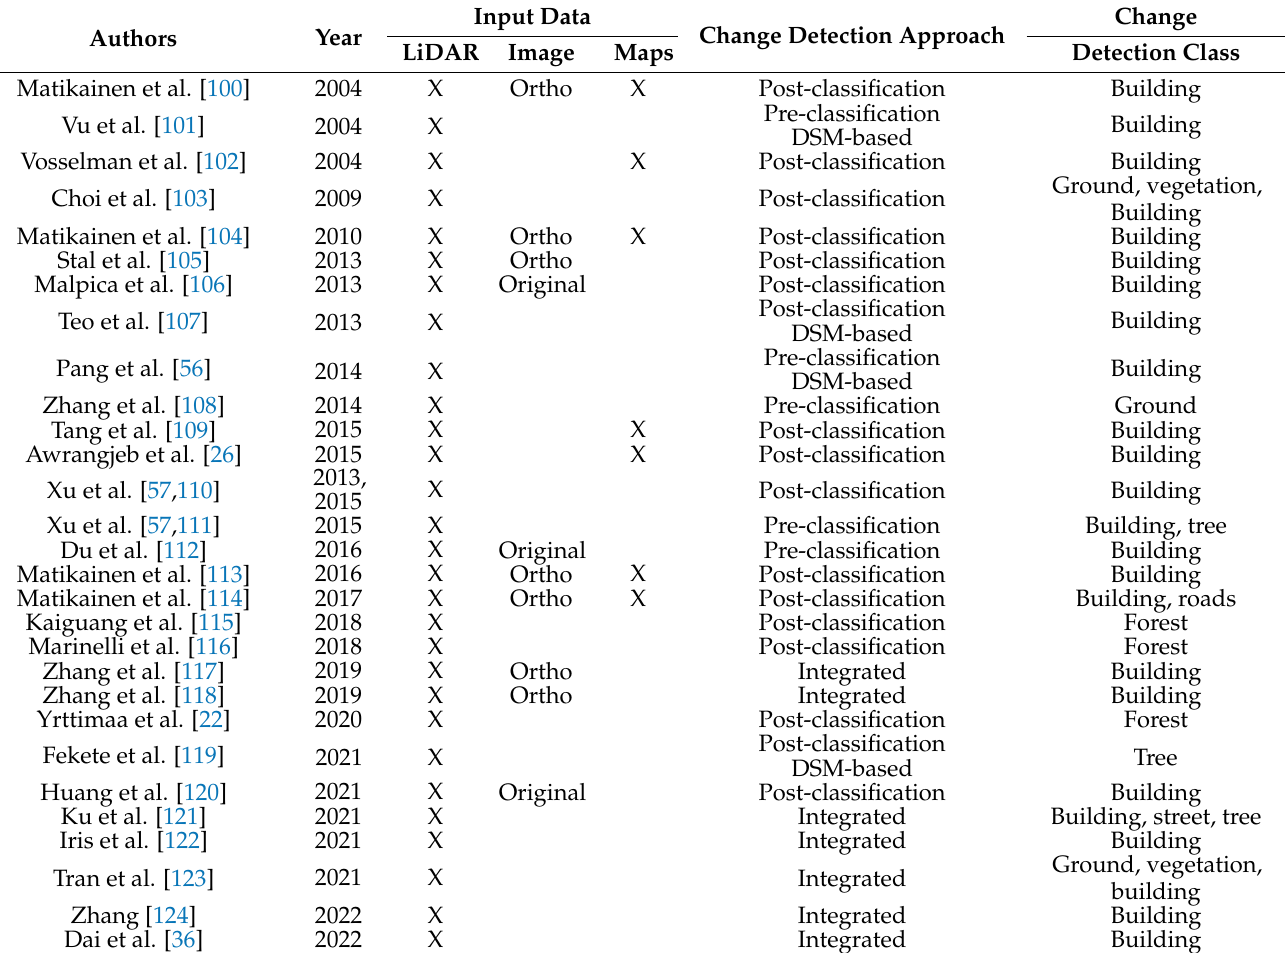
Table 2. Overview of 3D CD methods by input data, approach, and change detection